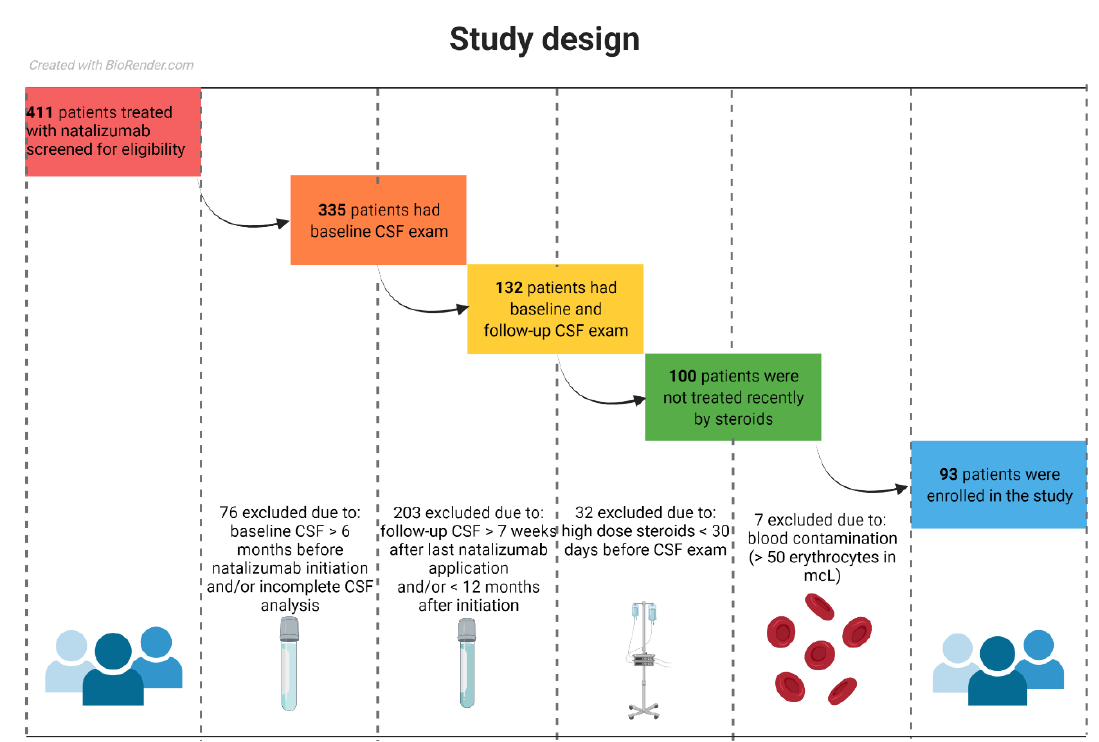
Figure 1. The study design. Originally, 411 patients who had received NTZ therapy were screened for their eligibility for the study. Exclusion criteria were applied to filter patients who had valid baseline and follow-up CSF data, had no history of recent high dose steroids and had CSF data without contamination by erythrocytes. Together, 93 patients fulfilled the inclusion criteria and were enrolled in the study.